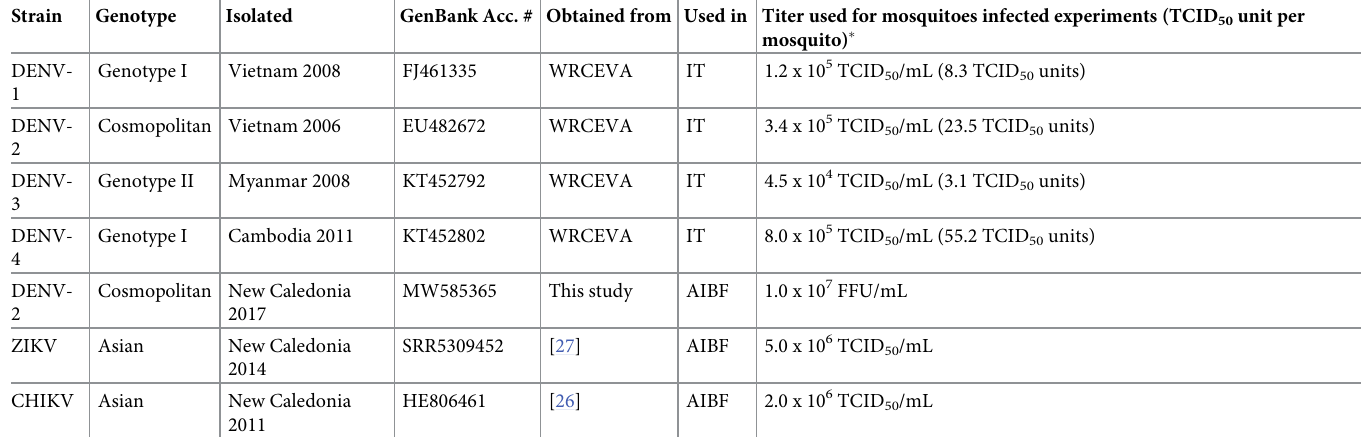
WRCEVA: World Reference Center for Emerging Viruses and Arboviruses; AIBF: Artificial Infectious Blood Feeding; IT: Intrathoracic injection. � Mean TCID 50 units per mosquito are given for IT experiments concentrations were then determined by TCID on C6/36 cells using monoclonal antibody 50 4G2 (provided by Roy Hall), followed by incubation with HRP-conjugated secondary antibod- ies, and TMB substrate as described in [24]. C6/36 cells were maintained at 28˚C with 5% CO2 in RPMI medium (Gibco, ThermoFisher) supplemented with 10% FBS (Gibco, Thermo- Fisher), 1% GlutaMAX (Gibco, ThermoFisher) and 2% HEPES (Gibco, ThermoFisher). Artificial infectious blood meal. For infectious blood meals, mosquitoes were reared under the same conditions as for the maintenance of the strains (see mosquito rearing section).